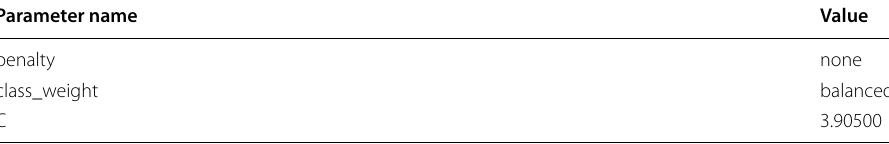
Parameter values for classifier yielding best results in terms of AUC